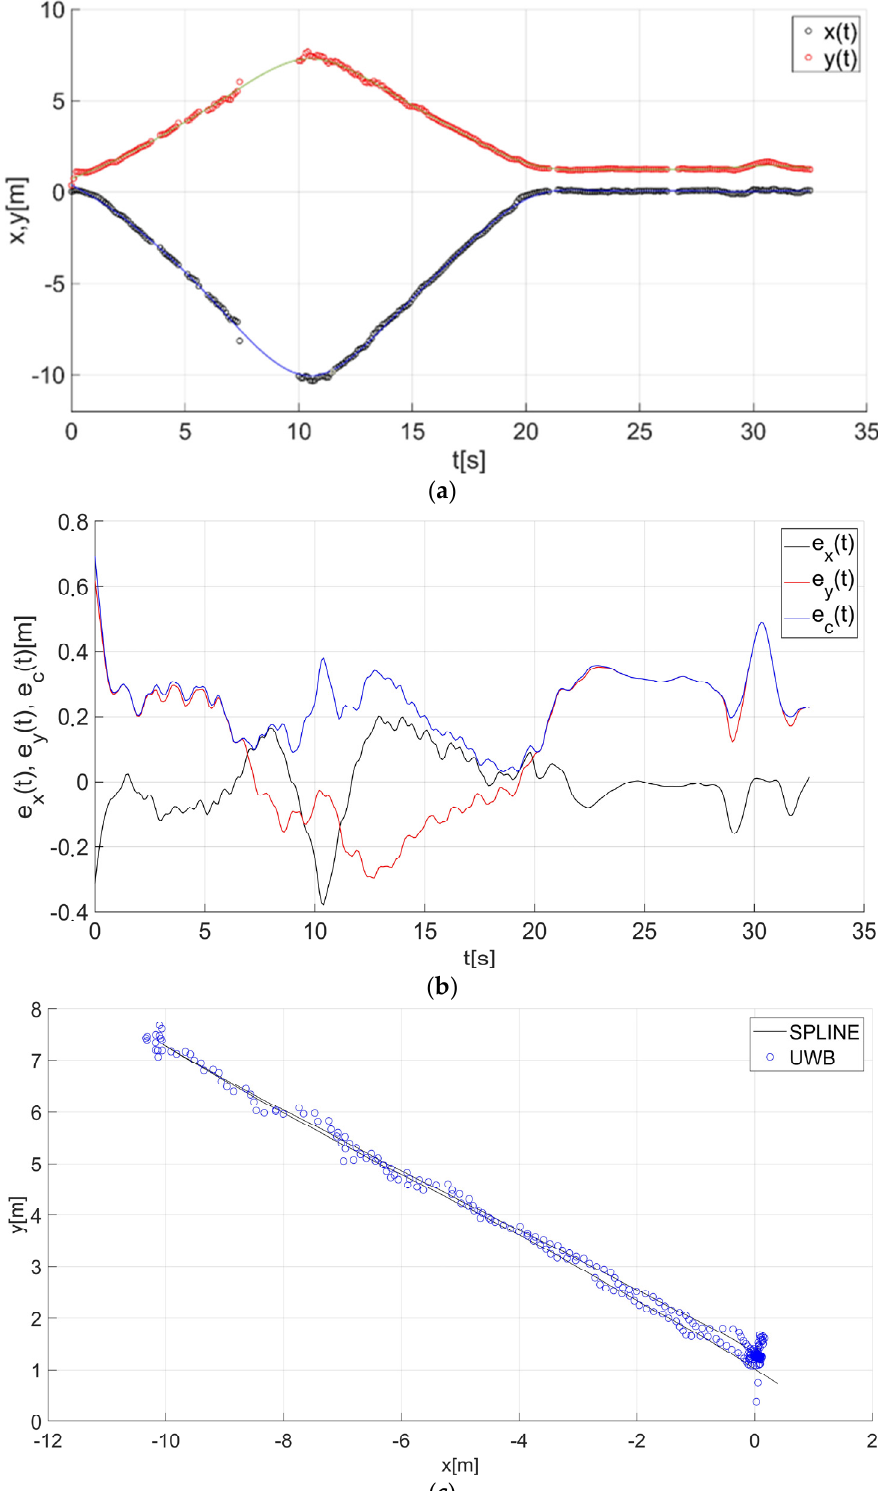
Figure 14. Results for the estimation of guide path no. 2 with the use of the smoothing spline: ( a ) the course of the guide’s location coordinates x(t), y(t) with their continuous estimates, ( b ) the course of the estimated location errors e x (t), e y (t), e c (t), ( c ) guide’s location along with the path estimation [6].